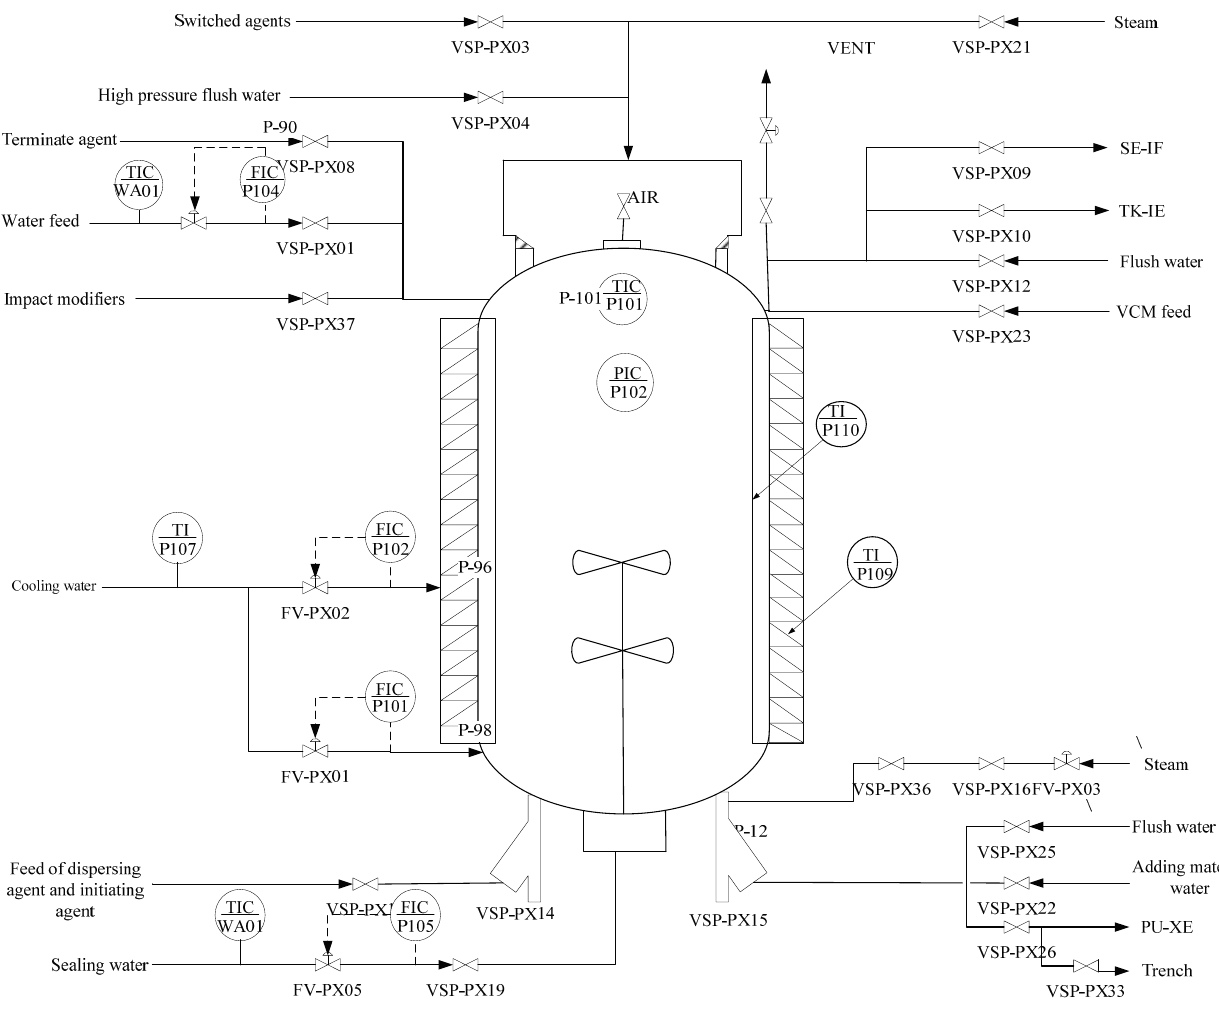
Figure 2. Technique flowchart of polymerization